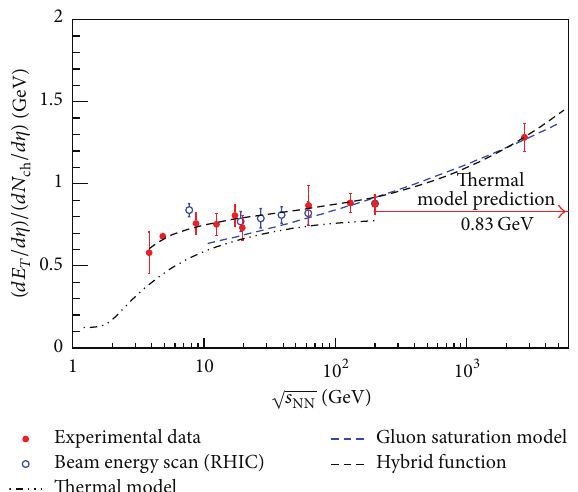
/𝑑𝜂 at midrapidity, as a ch Figure 44: Upper panel: the midrapidity ( 0 < 𝜂 < 1 ) 𝐸 𝑇 /𝑁 function of collision centrality for a wide range of energies spanning RHIC beam energy scan to LHC. Lower panel: the mean transverse momentum as a function of collision centrality, for both top RHIC energy and LHC 2.76 TeV center of mass energy. A similar spectral behaviour is observed for ⟨𝑝 𝑇 ⟩ and the barometric observable, /𝑁 𝐸 𝑇 ch